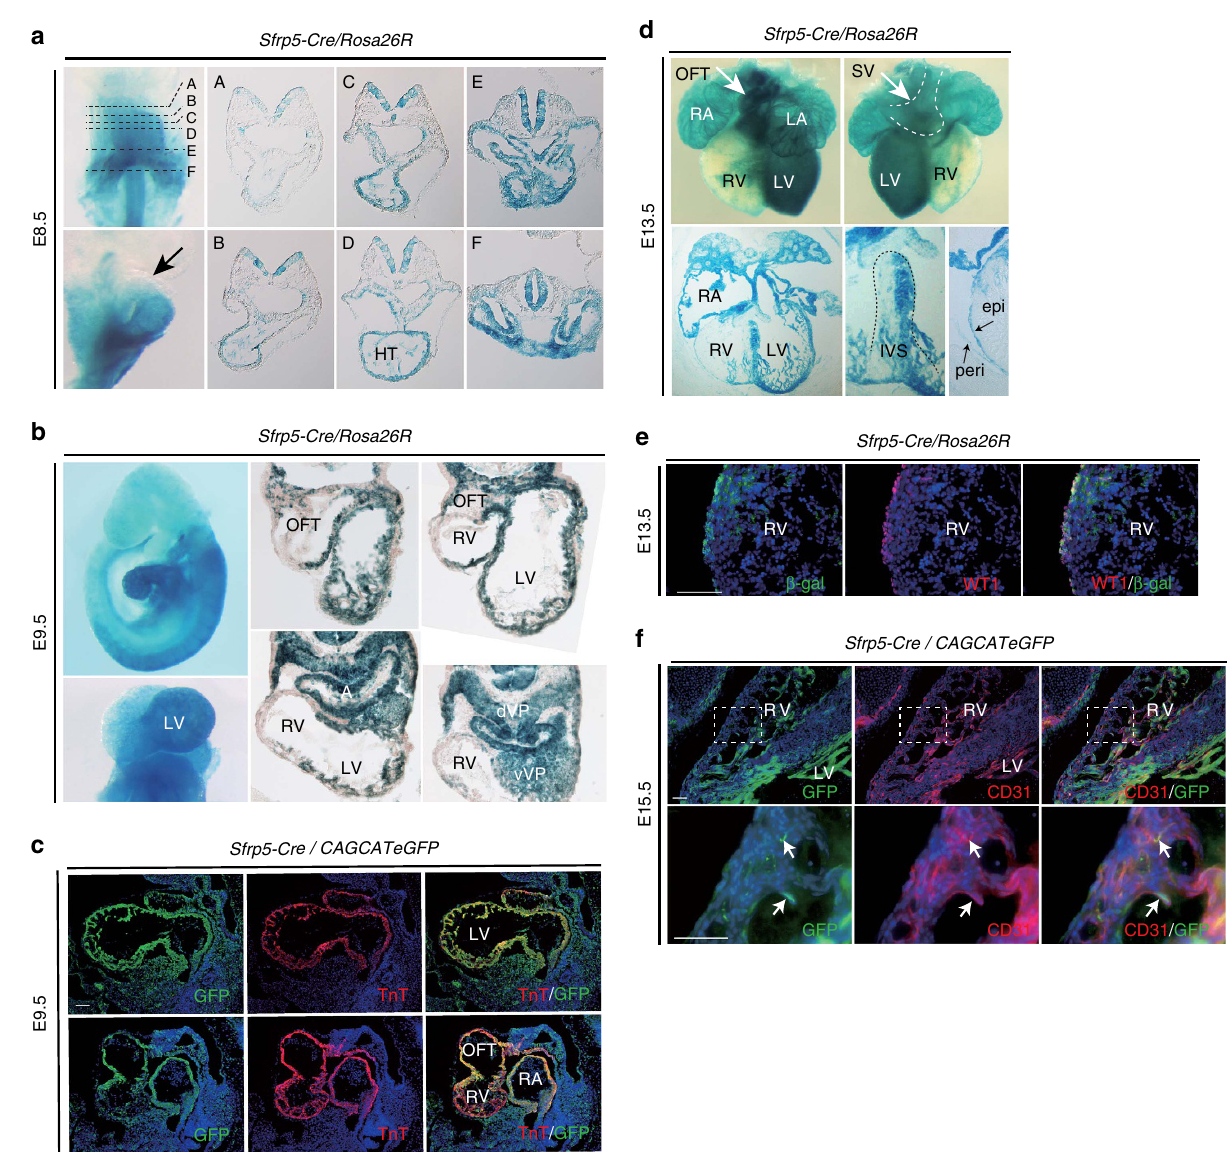
Figure 2 | Descendants of Sfrp5 -expressing cells contribute to the SVand all chamber myocardium except for the RV. ( a , b , d ) Whole-mount and section LacZ staining of Sfrp5-Cre/Rosa26R embryos at E8.5 ( a ), E9.5 ( b ) and E13.5 ( d ). HT: heart tube; dVP: dorsal venous pole; vVP: ventral venous pole; epi: epicardium; peri: pericardium, IVS; interventricular septum. ( c , e , f ) Double immunohistochemistry of Sfrp5 - Cre / CAG-floxed-CAT-eGFP ( c , f ) or Sfrp5 - Cre / Rosa26R ( e ) embryos at E 9.5 ( c ), E 13.5 ( e ) and E15.5 ( f ), using anti-GFP or anti- b -gal (green) antibodies with anti-TnT, anti-Isl1, anti-WT1 or anti-CD31 antibodies (red). Rectangles in upper panels ( f ) are magnified in lower panels. Arrows indicate cells co-expressing YFP and CD31 ( f ). Scale bars ¼ 50 m